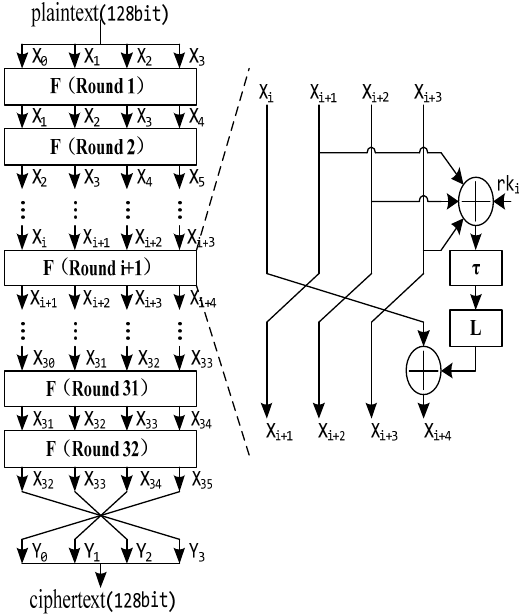
Figure 1. SM4 encryption process.